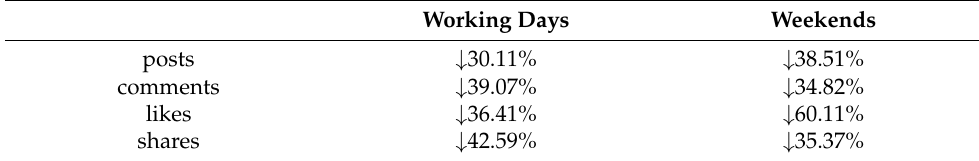
Table 6. Comparison of the trend level (regressor) of the regression model.